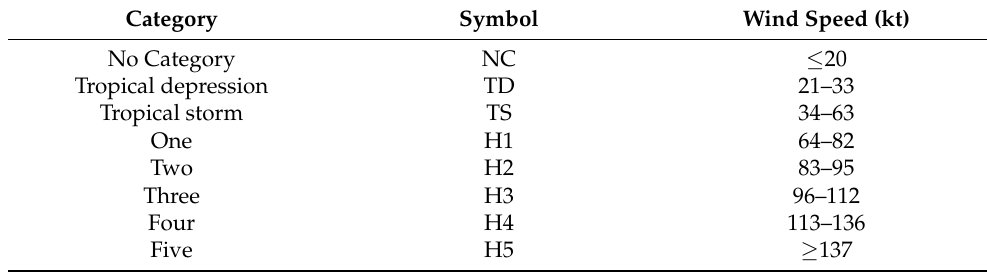
Table 2. Saffir–Simpson Hurricane Wind Scale and associated categories.